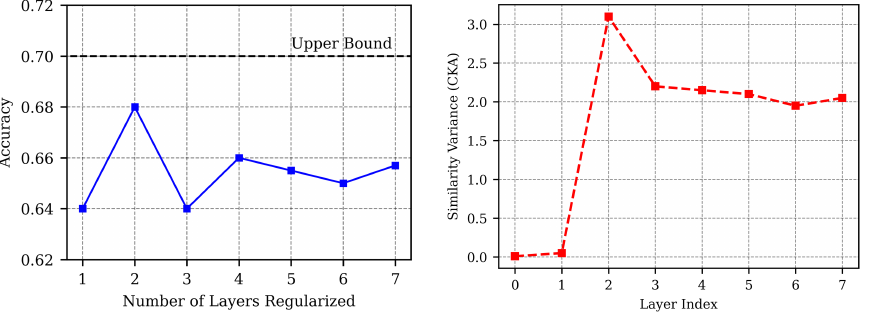
Figure 6. Accuracy with respect to the number of layers regularized and variance in similarity measures between clients on CIFAR-10 and α =